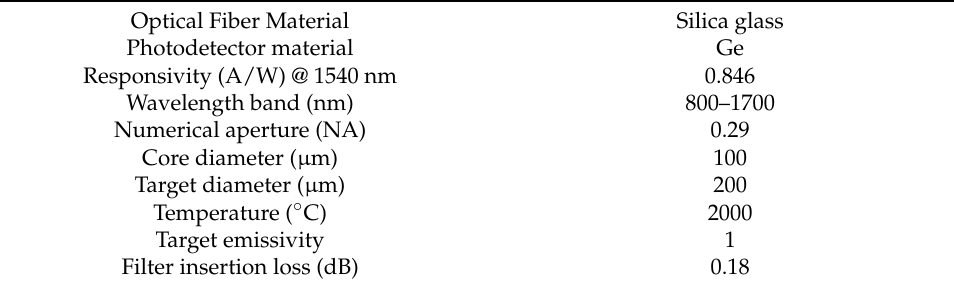
Table 2. Simulation parameters used for the model validation